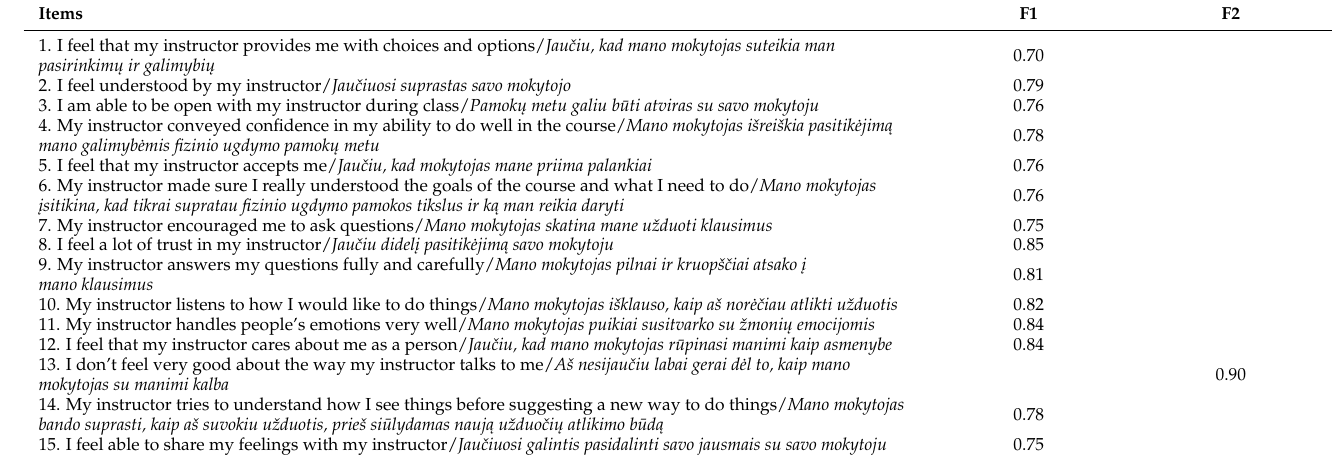
Table A1. The Learning Climate Questionnaire (LCQ) English/ Lithuanian statements with the factor loadings from the exploratory factor analysis ( n =